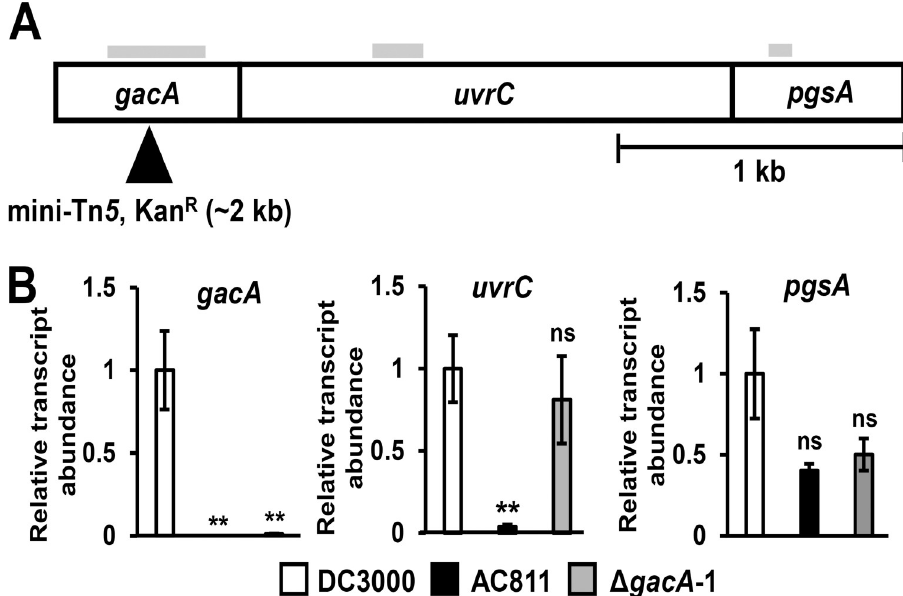
Fig 2. Expression of uvrC is decreased in AC811 but not in Δ gacA -1. (A) Schematic of the putative gacA-uvrC-pgsA operon in DC3000. Filled triangle shows mini-Tn 5 insertion site in AC811. Solid black vertical bars indicate predicted translation start sites of uvrC and pgsA . Shading above each gene indicates regions of mRNA transcripts amplified by qRT-PCR. (B) Quantitative RT-PCR analysis of gacA , uvrC , and pgsA transcripts. Transcript abundances were normalized to gyrA transcripts using the PCR efficiency – ΔΔ Ct method and calculated relative to transcript levels measured in wild type DC3000. Graphed are means ± SE from data pooled across two independent experiments with two technical replicates each; n = 4. Asterisks denote statistical significance from pairwise t -tests performed between the indicated strains and DC3000. �� p < 0.01; ns = no significant difference ( p > 0.05).